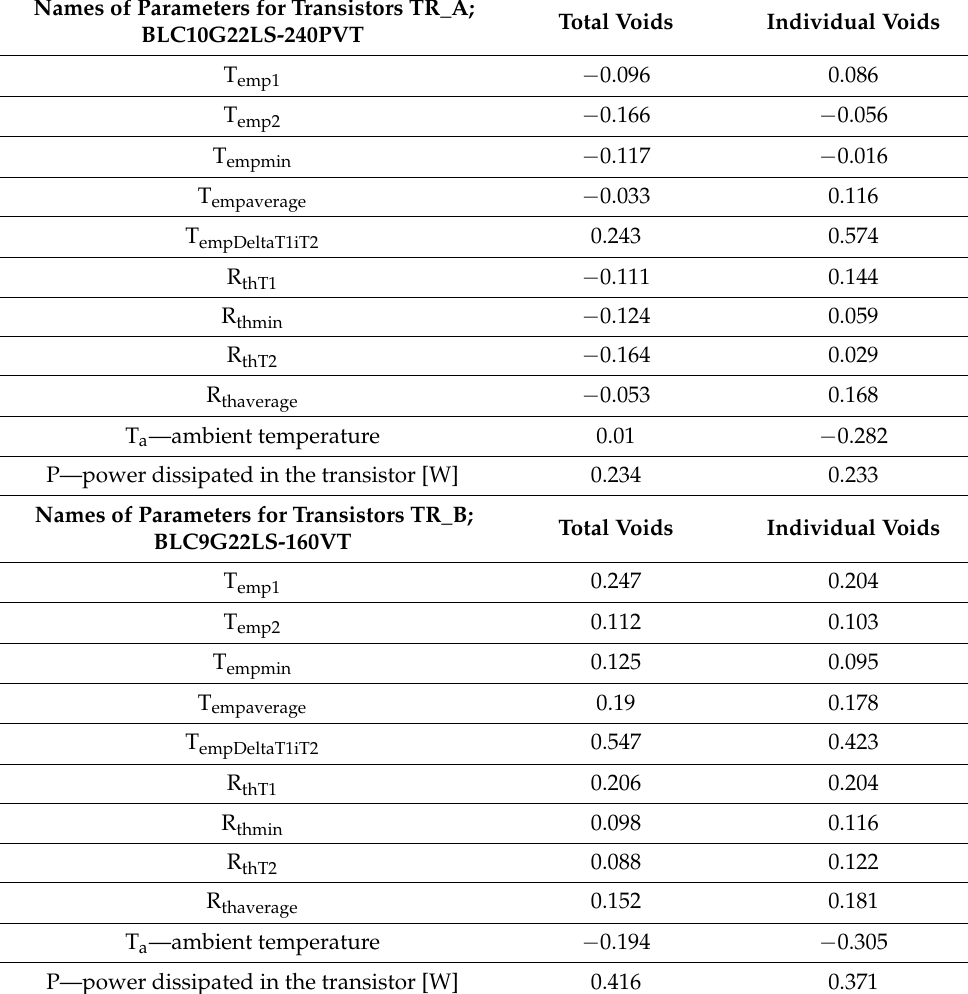
Table 2. Set of r-value correlation coefficients showing the statistical impact of the individual and total void sizes on selected thermal parameters of the tested